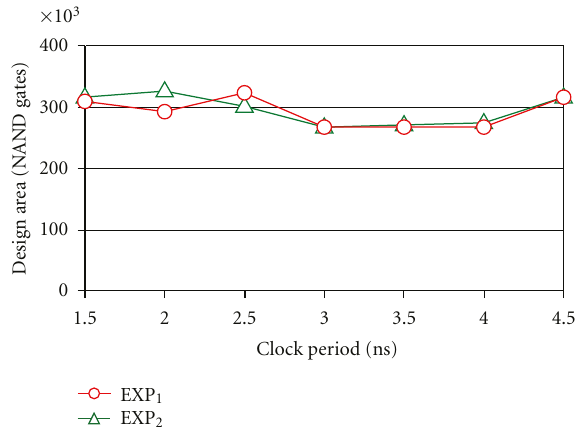
Figure 10: Area when the synthesis is constrained by the small set of operators for low-precision profile—65 nm ASIC technology.